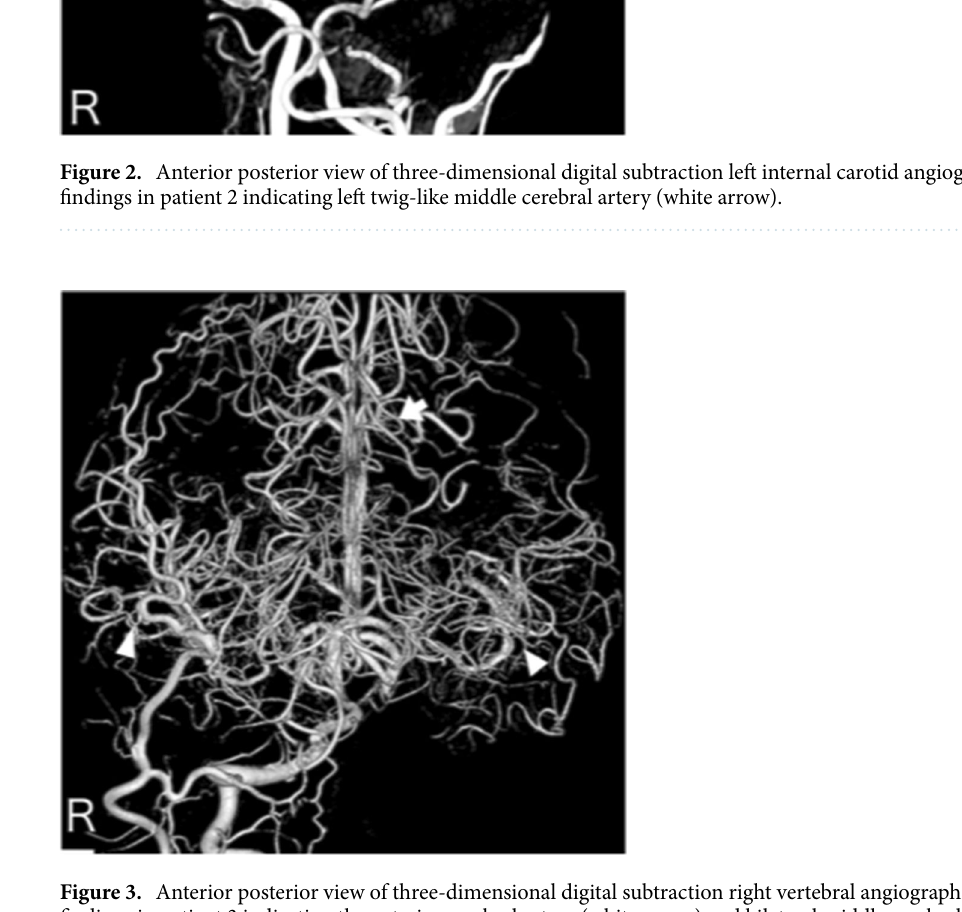
Figure 3. Anterior posterior view of three-dimensional digital subtraction right vertebral angiographical findings in patient 3 indicating the anterior cerebral artery (white arrow) and bilateral middle cerebral artery (white arrow heads) flow from the posterior communicating